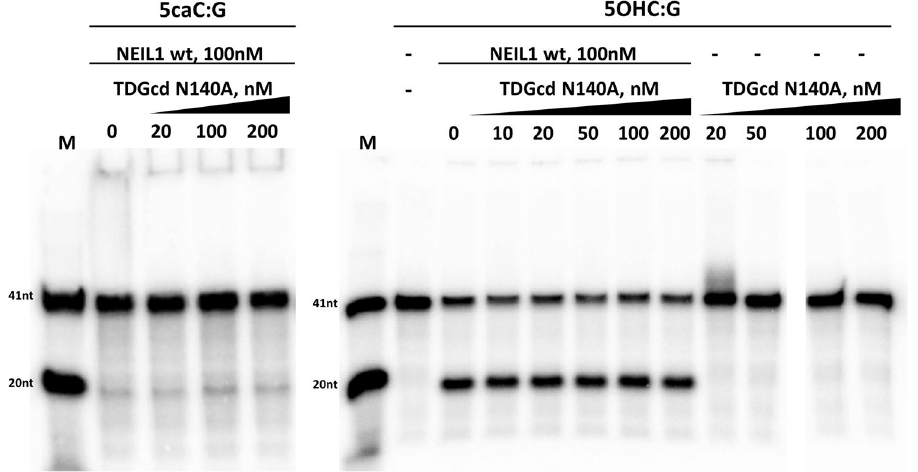
Figure 9. NEIL1 glycosylase activity is not affected by TDGcd: 100 nM NEIL1 and increasing amounts of the catalytically impaired TDGcd N140A were incubated (37 °C, 60 min) with 20 nM dsDNA containing a radiolabelled strand containing either a 5caC or 5OHC base opposite G. After the enzymatic reaction, reaction products were subjected to alkaline conditions to break DNA strands at